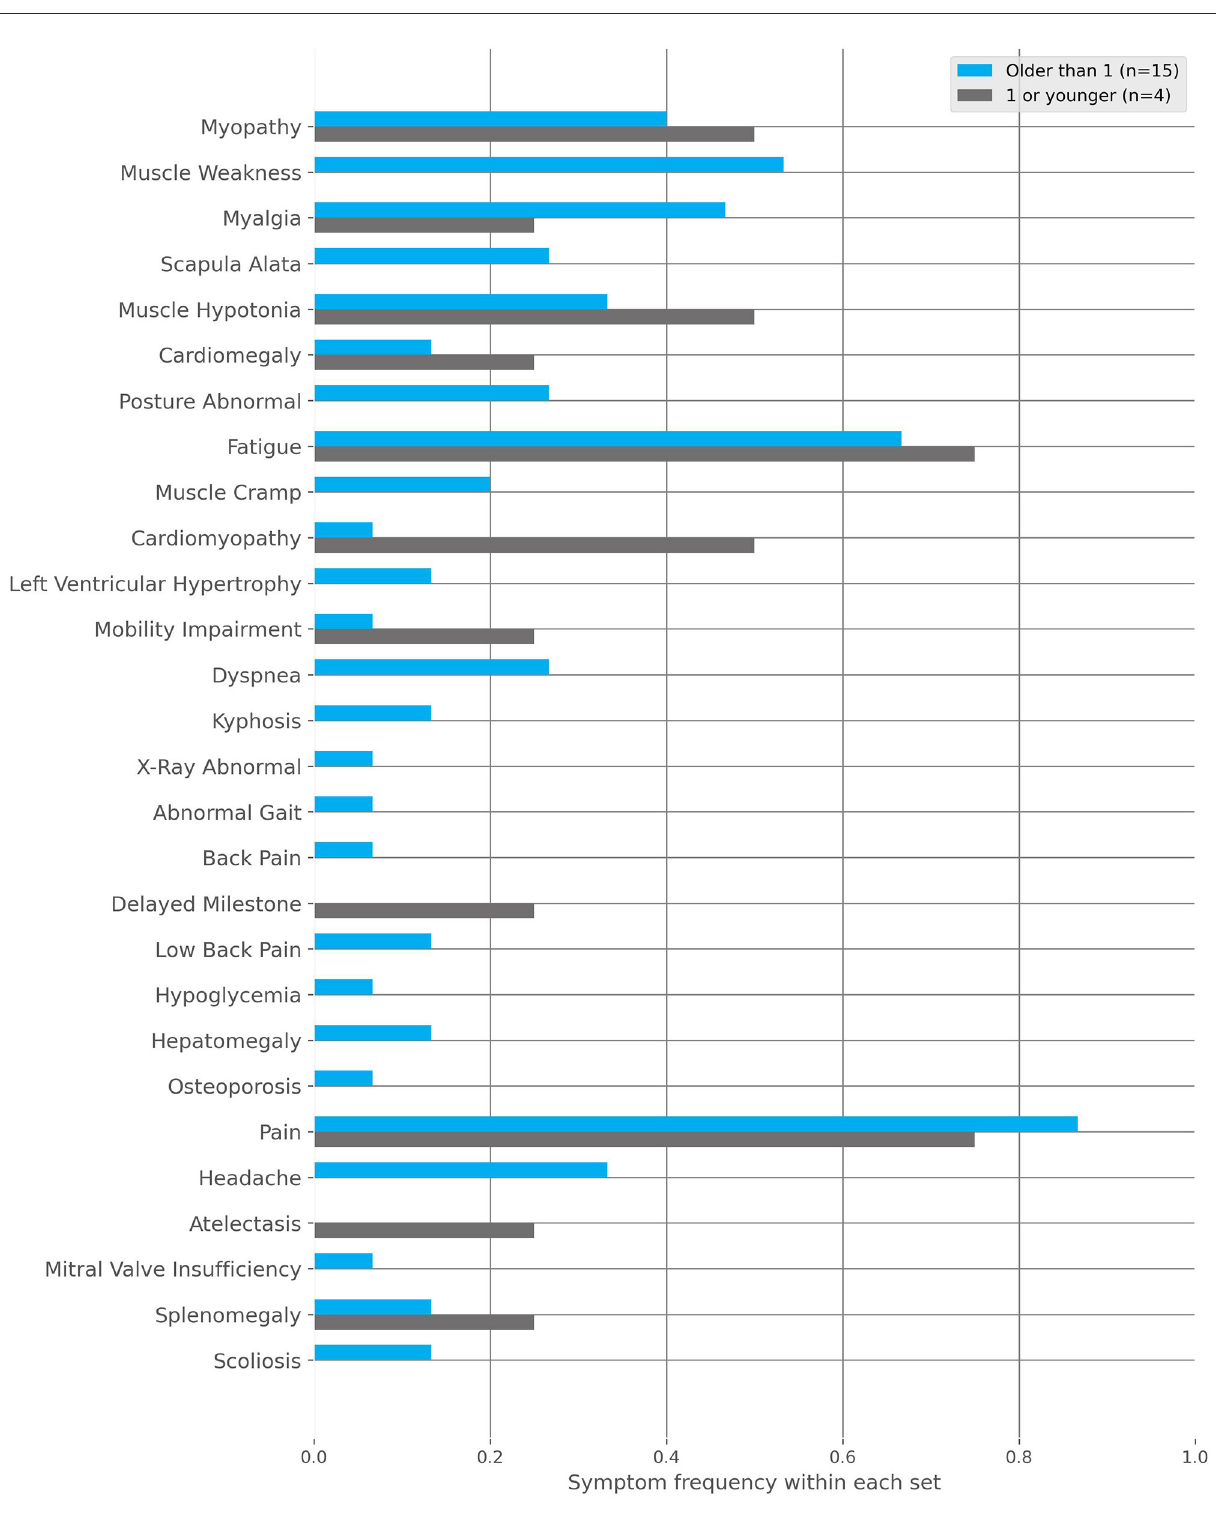
FIGURE5 The frequencies of characteristics found within the Infantile-onset Pompe disease (IOPD) and late-onset Pompe disease (LOPD) subgroups to the positive cohort. These subgroups are defined by the first occurrence of symptoms, specifically before or after 1 year of age, respectively.